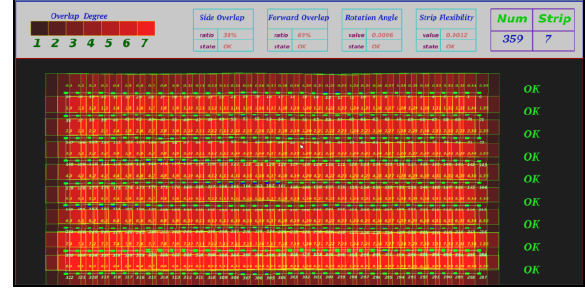
Figure 9. Geometry quality evaluation for aerial